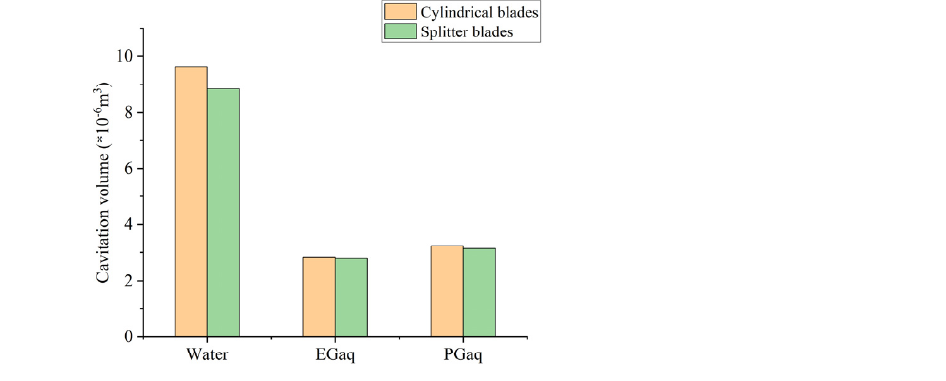
Figure 21. Volumes of cavitation zone in different impellers and coolants at 60 °C with an inlet pressure of 0.4 atm.